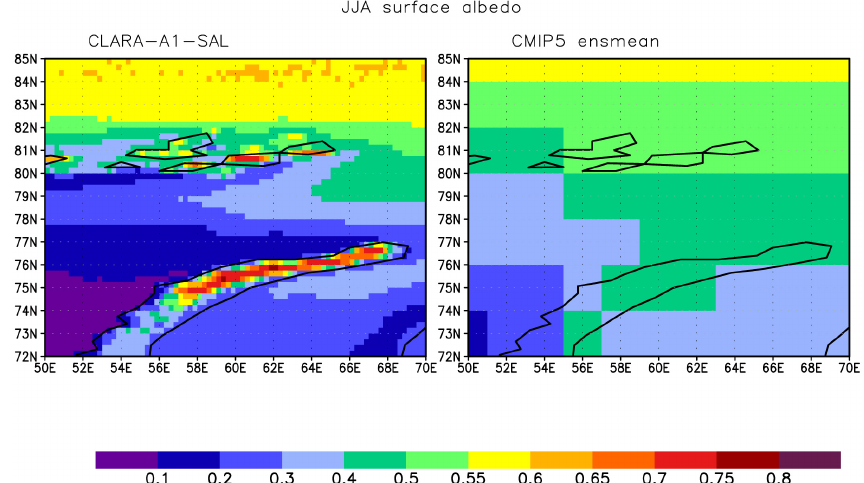
Fig. 1. Summer (JJA average) surface albedo in the northeastern Barents Sea region, averaged over 1982–2005, in CLARA-SAL on a 0.25 ◦ × 0.25 ◦ grid and in the CMIP5 ensemble mean interpolated on a 2 ◦ × 2 ◦